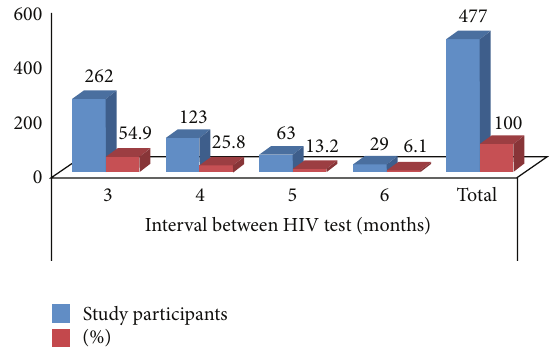
Figure 2: Time interval between repeat HIV test from booking test.